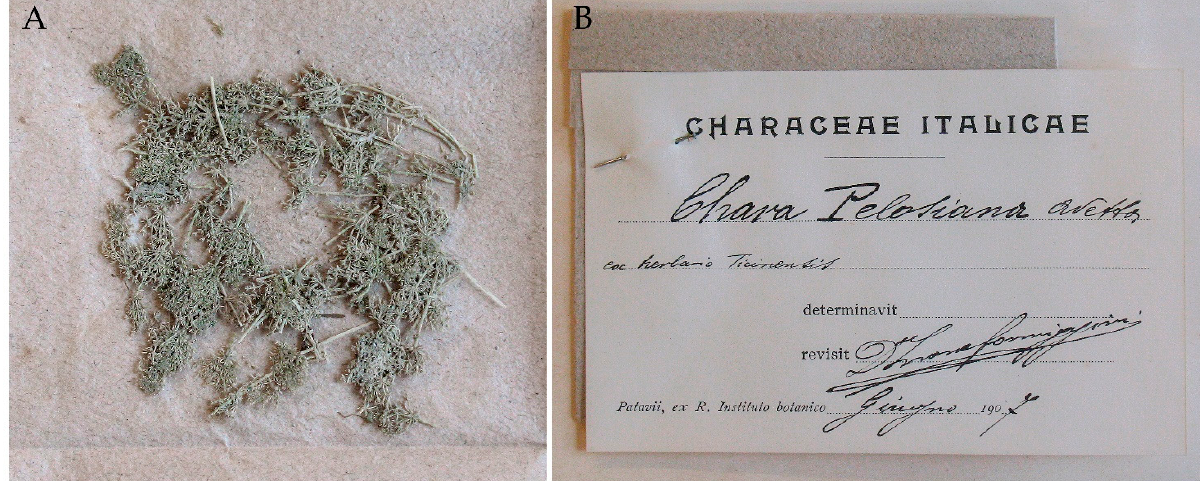
Figure 7. ( A ) PAD portion of Chara pelosiana removed from PAV specimen. ( B ) Formiggini’s revision label.